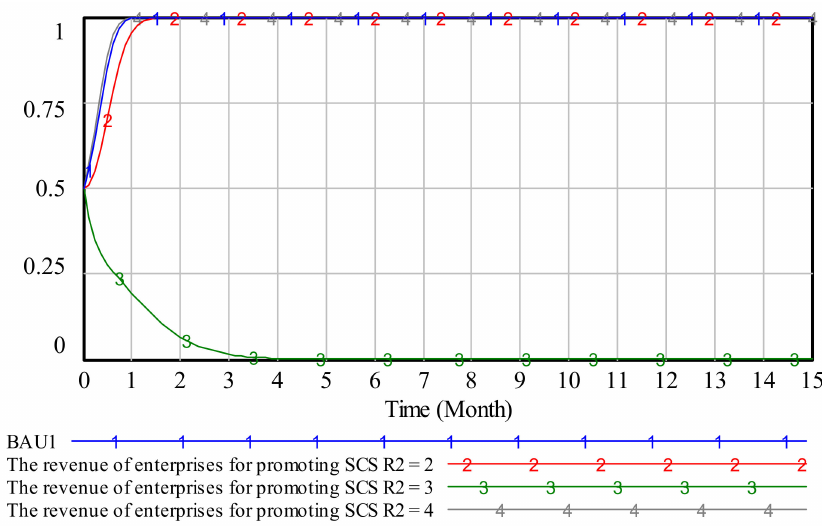
Figure 10. Impact of R 2 on the enterprise strategy selection in the BAU1